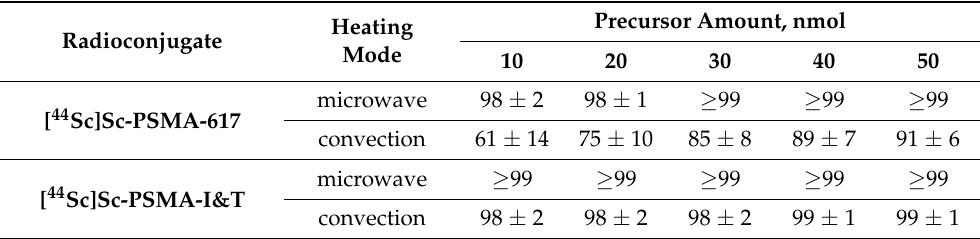
(mean ± SD, %; n = 5; 95 ◦ C, 30 min, V = 1.0 mL, pH =